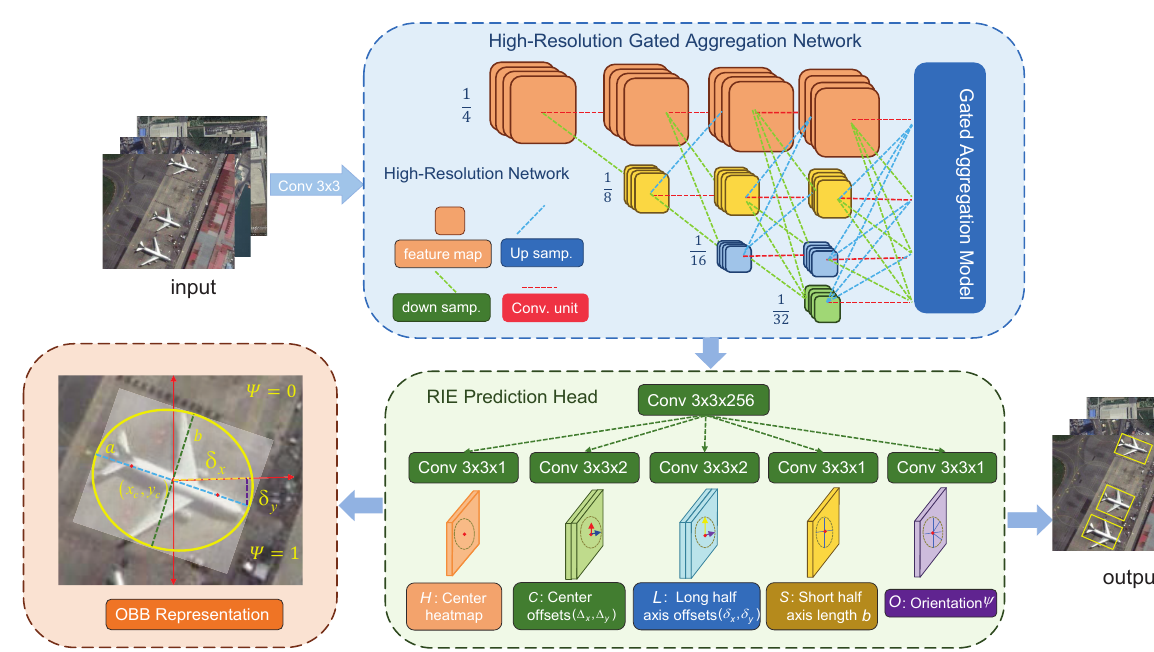
Figure 2. Framework of the our method. The backbone network, HRGANet, is followed by the RIE prediction model. The HRGANet backbone network contains HRNet and GAM. Up samp. represents a bilinear upsampling operation and a 1 × 1 convolution. Down samp. denotes 3 × 3 convolution with a stride of 2. Conv unit. is a 1 × 1